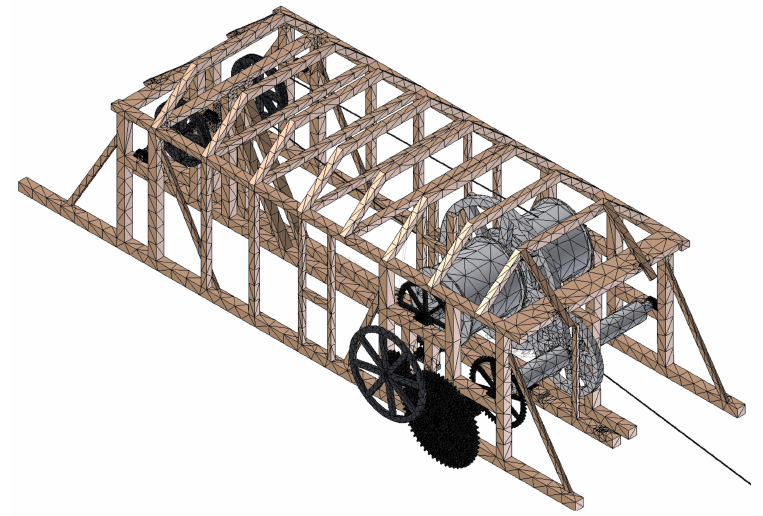
Figure 14. Automatic mesh obtained from the Hay inclined plane.